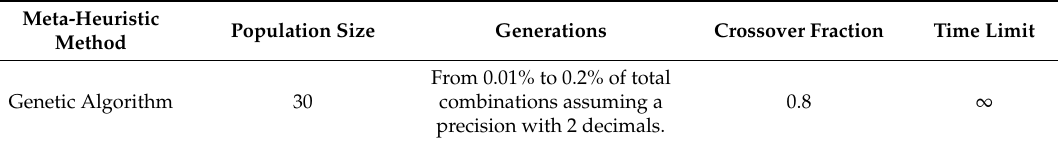
Table 1. Several configuration parameters of the genetic algorithm.